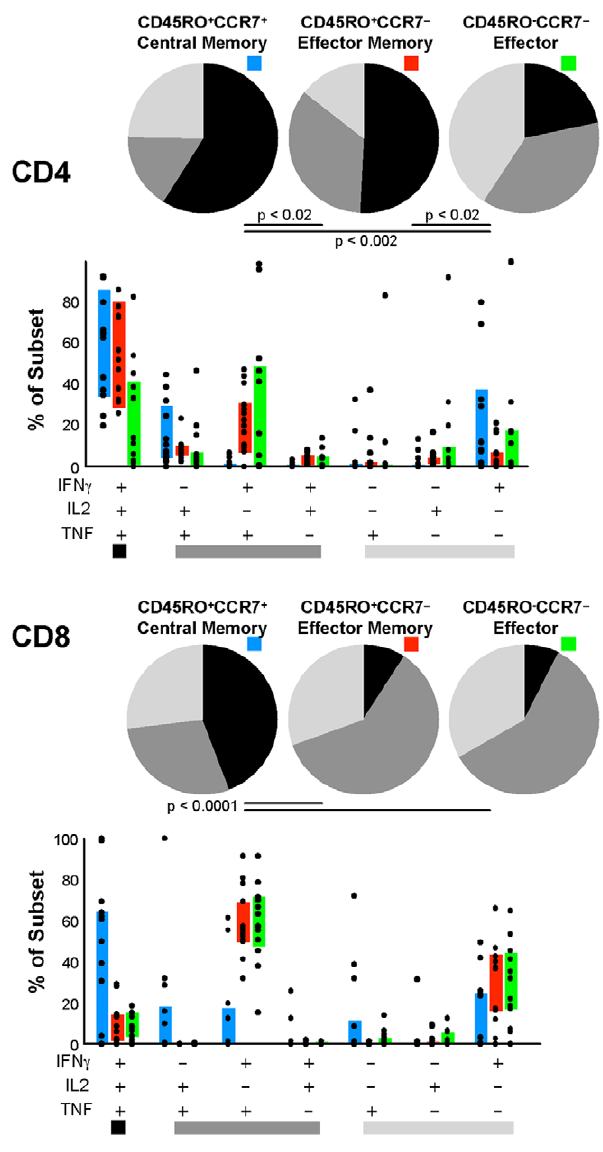
Figure 4. The quality of the response within T CM , T EM , or T EF cells. Data for each subject is averaged over time points (there was no statistically significant change in quality over time within each subset). T CM cells have significantly more polyfunctional T cells than T EM or T EF